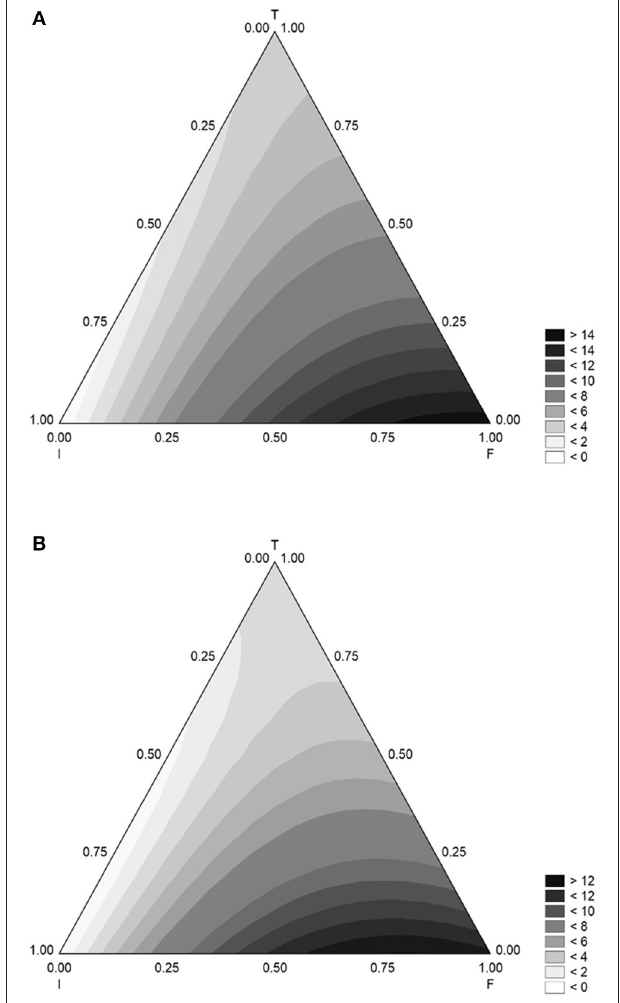
FIGURE 4 | Triangular surfaces for the effect of flour (F), inoculum (I), and temperature (T) on the time before the beginning of acidification (parameter α ) of L. delbrueckii subsp. bulgaricus . (A) Gluten Friendly Flour; (B) Control